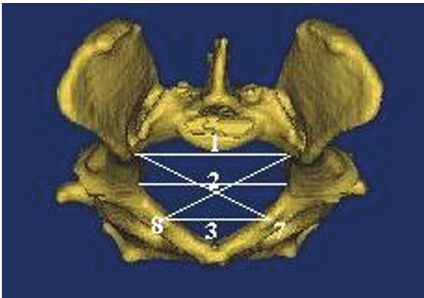
Figure 2: Measurements on facies cranialis of pelvic cavity.